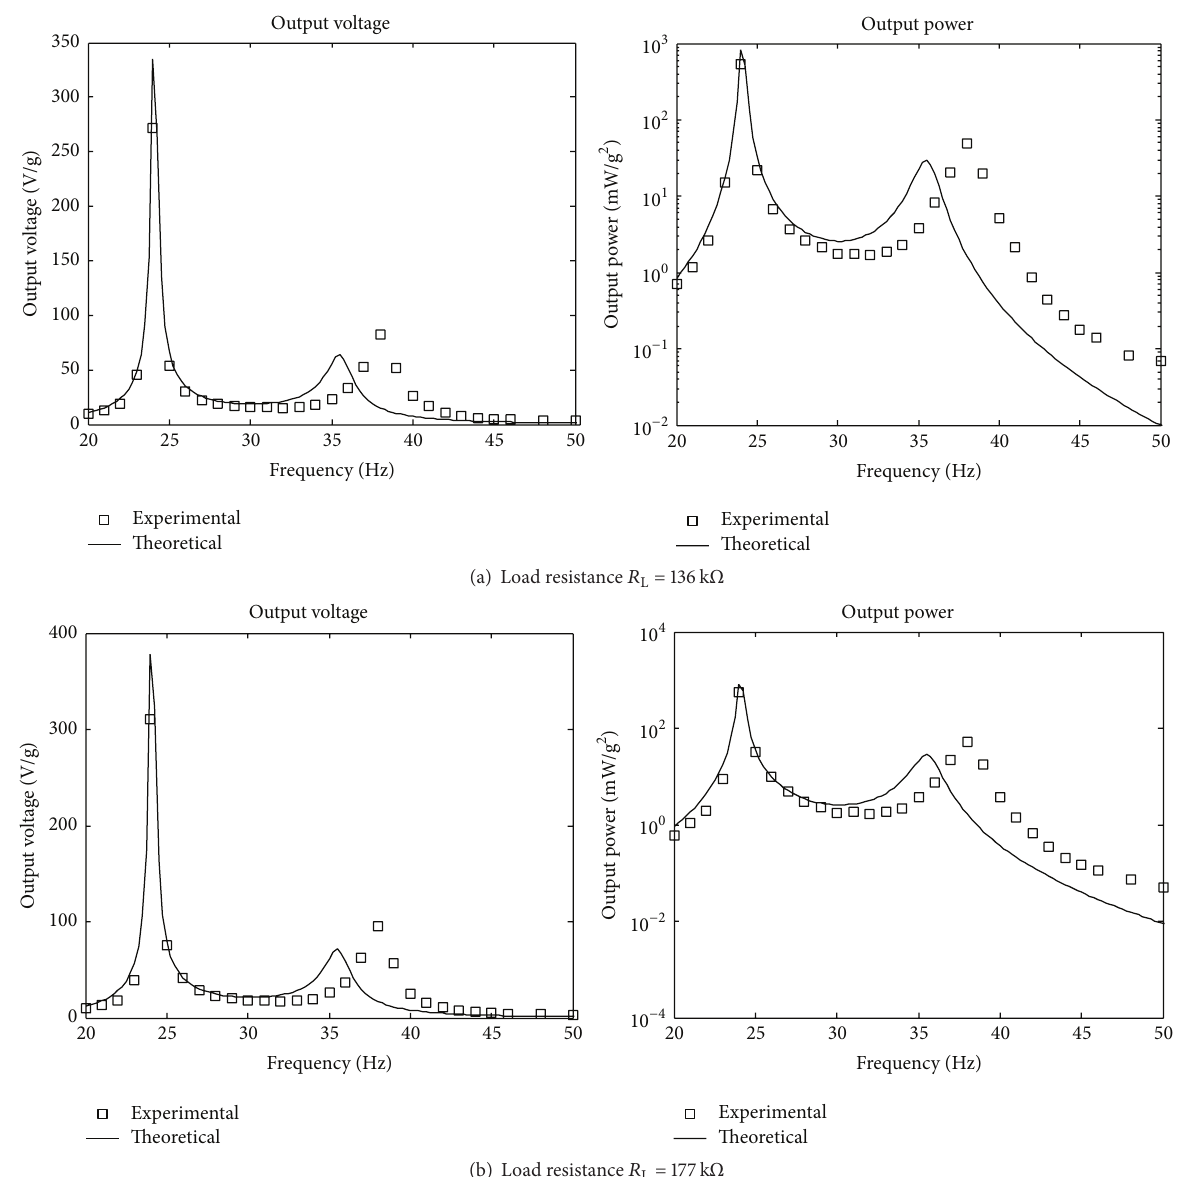
Figure 17: Frequency responses of output voltage and power of the BPEH under different load resistances when 𝑎 = 10 and 𝑟 = 7 .